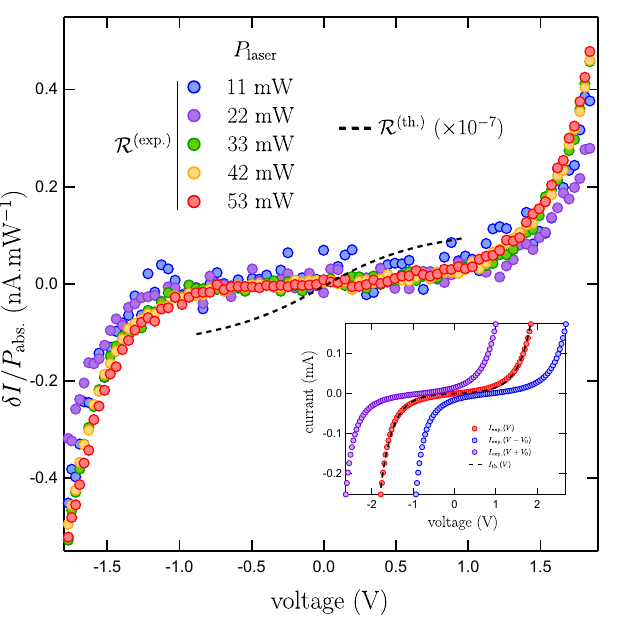
Fig. 4 Voltage dependence of the photon-assisted current under an illumination at λ = 1550 μ m and T 0 = 2.8 K. Symbols are mean from 33 measurements per point. The error bars indicate the standard deviation. The light intensity is 16 W. cm − 2 . The black dashed line corresponds to the measured right-hand side of Eq. (1). The only fi tting parameter is the value of V ac ¼ V Tucker which is adjusted with the slope at zero bias. The black op solid line corresponds to the numerical simulation of Eq. (4) using